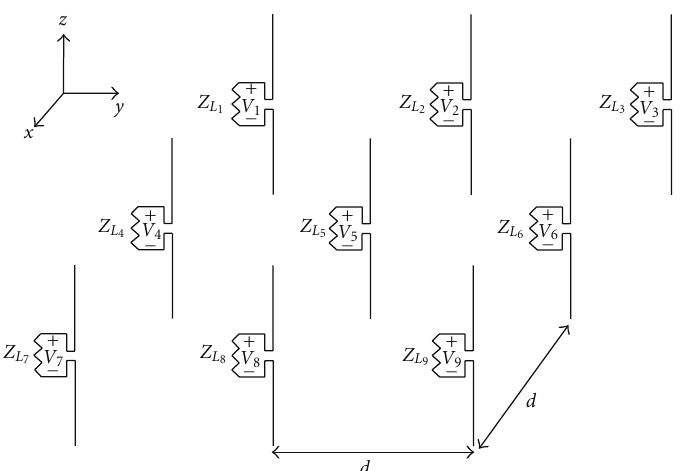
Figure 3: Nine-dipole array geometry used for the wideband analysis. The dipoles are placed in a planar array arrangement where the separation between them is given by d . The terminal voltages are measured across the load impedances located at the center of each of the